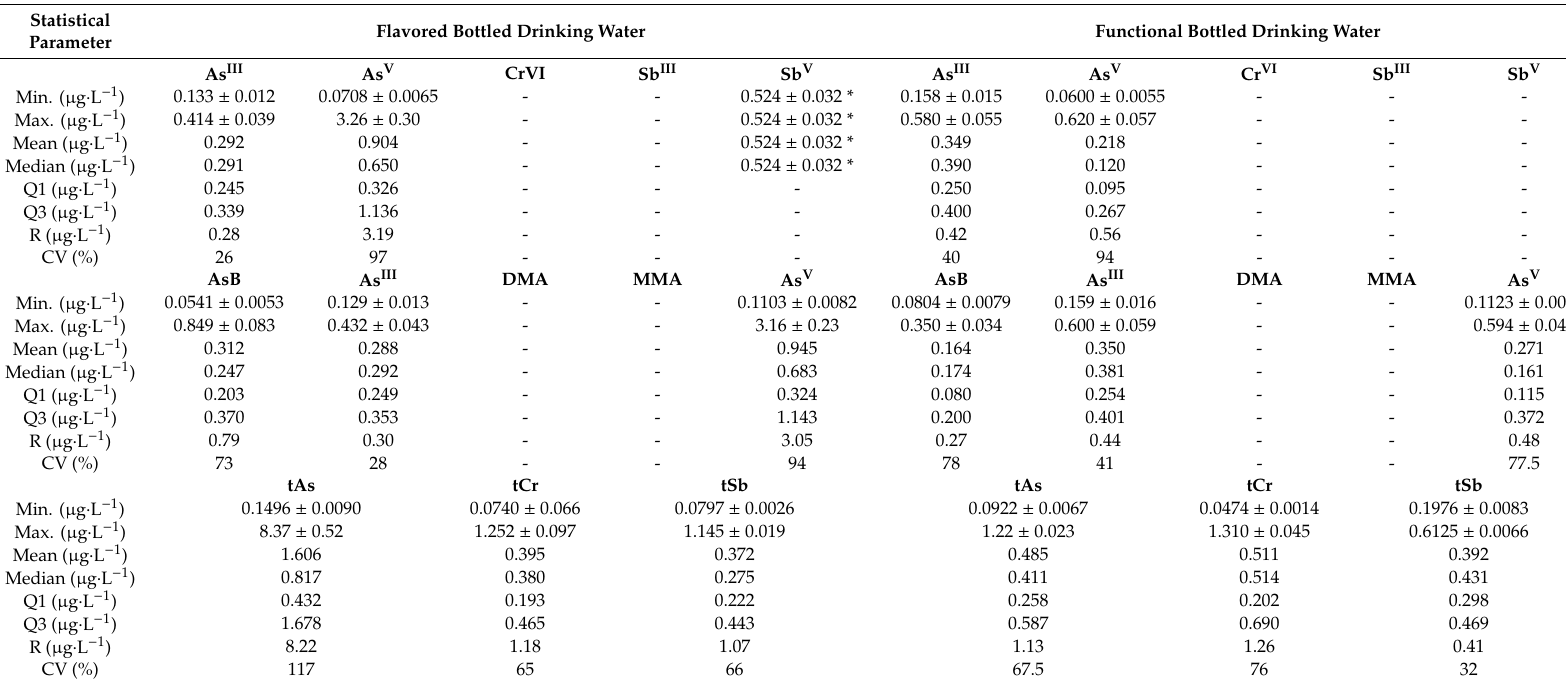
Table 1. Summarized results for total amounts of As, Cr, and Sb and speciation analysis results for flavored and functional bottled drinking water samples. Statistical